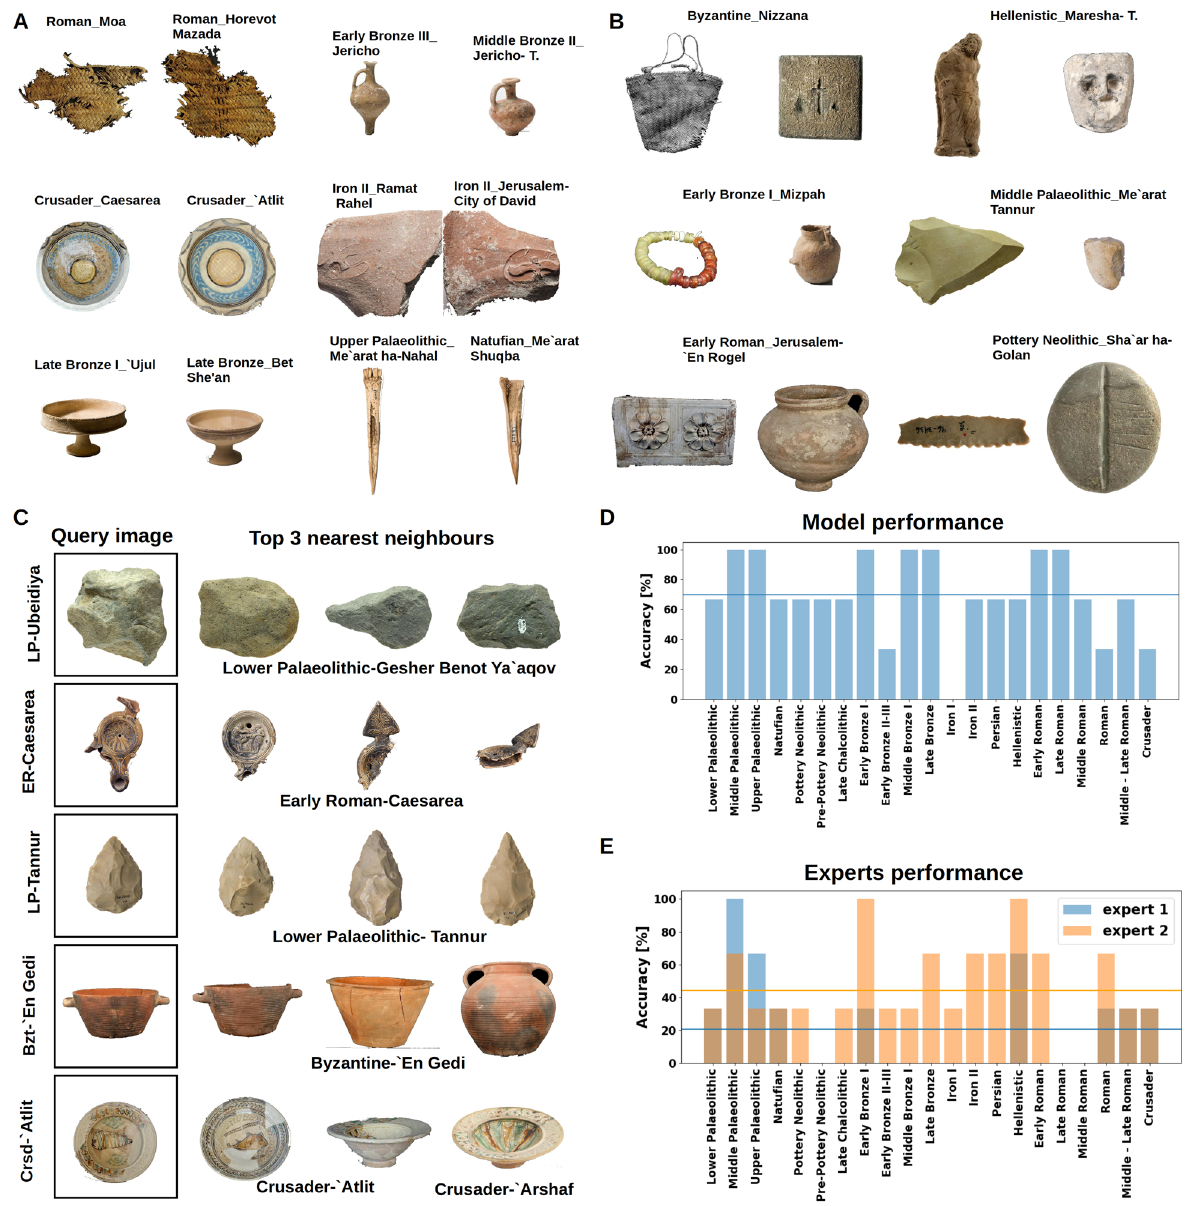
Fig. 2 Classi fi cation and CNN model performance. A Nearest neighbour pairs of artefacts from different classes (the image on the left derives from the validation set, and the image on the right derives from the training set). B Pairs of distinct images that derive from the same class. C Validation set query images (left column) and the top-3 training set nearest neighbours. D A histogram of model performance for fi ne-period prediction on 63 randomly picked images (3 images per period); the straight horizontal line marks the average prediction accuracy (69.84%). E A histogram of two archaeologists' performances (blind experiments) for the same 63 artefact images used for D; the horizontal lines mark the average prediction accuracies for each archaeologist (44.44,